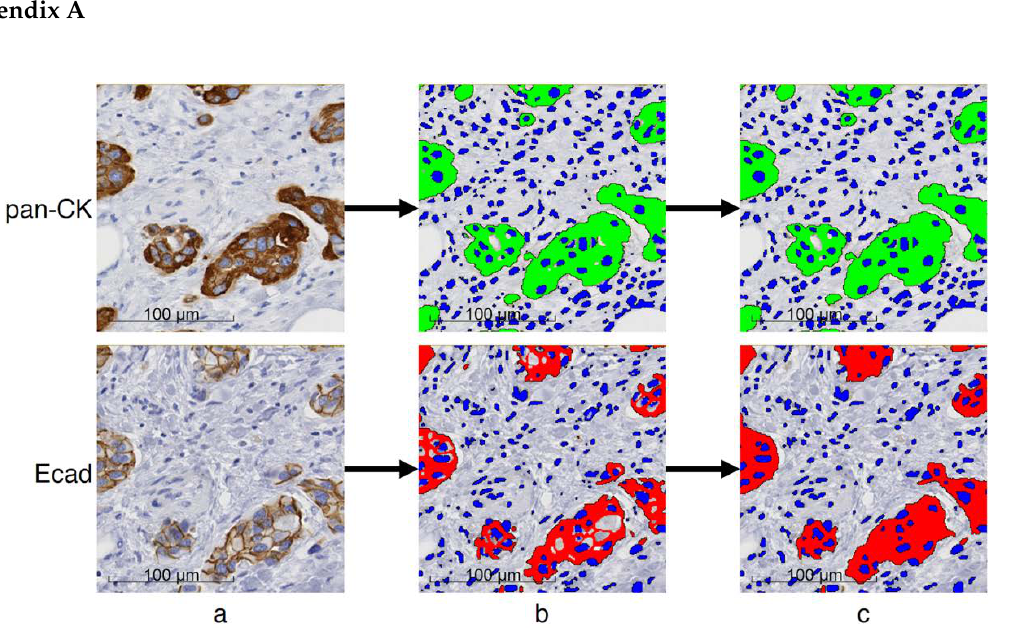
Figure A1. Image processing to quantify cells expressing pan-CK and E-cad on two consecutive slides. ( a ) Input images shown at 20× magnification (0.453 µm-side pixel), ( b ) intermediary result after the thresholding step identifying DAB staining and cell nuclei, and ( c ) final result after both thresholding and post-processing to identify whole cell areas except the nuclei. Table A1. Cox regression model for disease-free survival. The model includes the clinicopathological variables selected using univariate survival analysis (with p < 0.10).